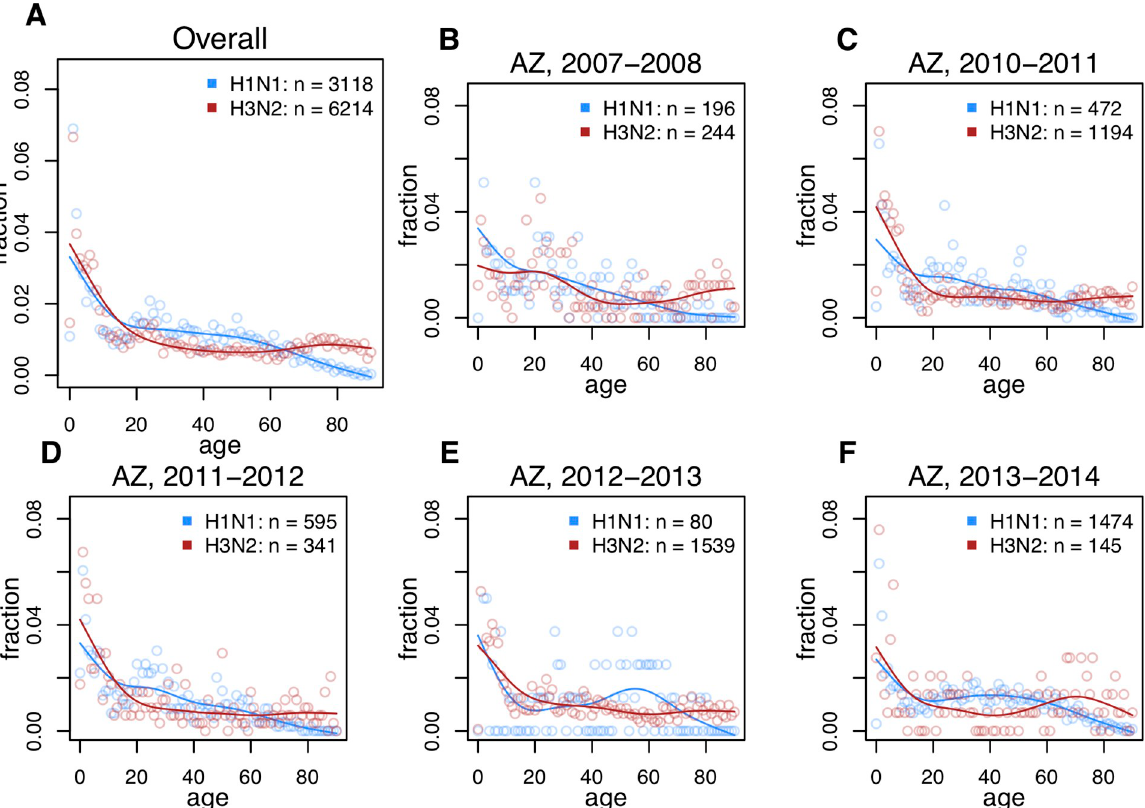
Fig 2. Observed age distributions, Arizona. Points show fraction of confirmed H1N1 or H3N2 cases observed in each single year of age. Lines show a smoothing spline fit to observed distributions. (A) All confirmed cases in the data (aggregate across all seasons). ( B-F ) Age distributions from individual seasons in which both H1N1 and H3N2 circulated (seasons with � 50 confirmed cases of each subtype are shown here. See S1 Fig. for all seasons).